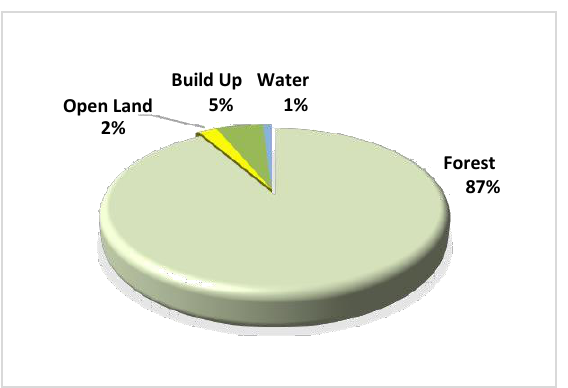
Graph 1: Supervised Classification Area Percentage (%) Margalla Hills Year 2000.